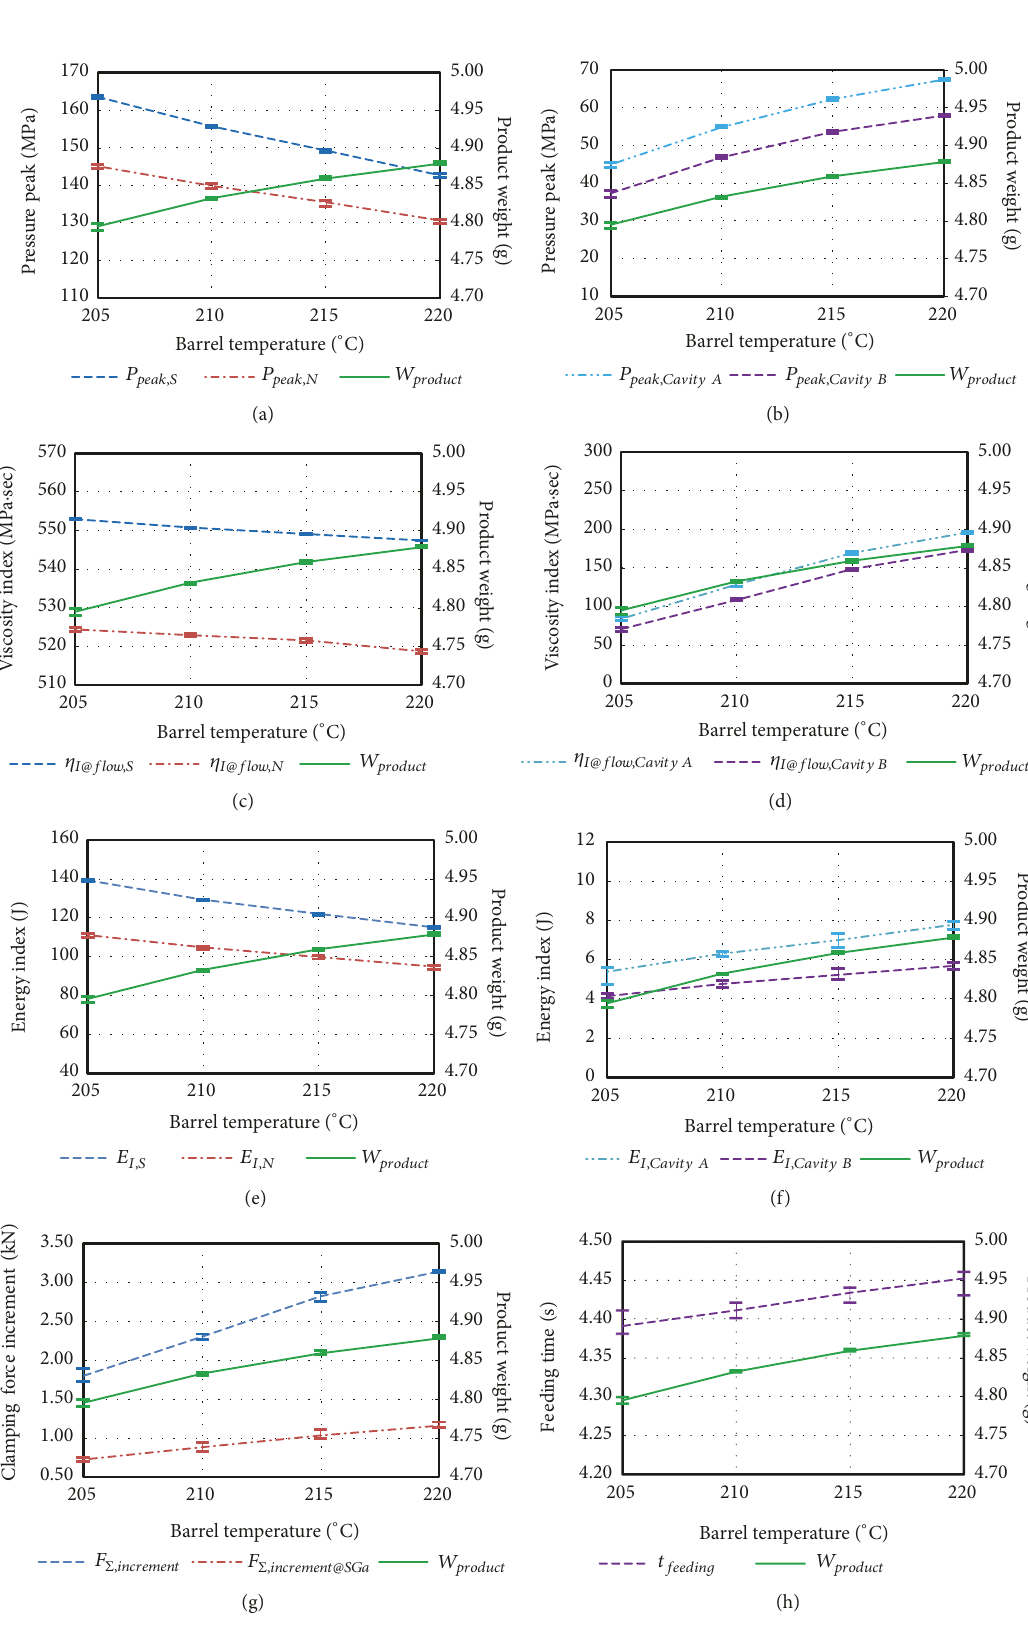
Figure 9: Variation of quality indexes and product weight with barrel